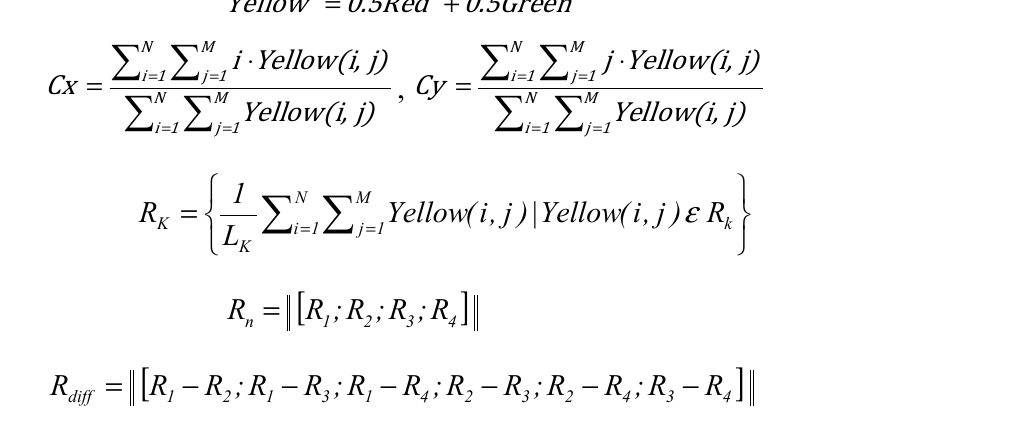
Figure 6. ( a ) Yellow component of healthy pepper leaf. ( b ) Sectioned healthy pepper leaf in four regions (R